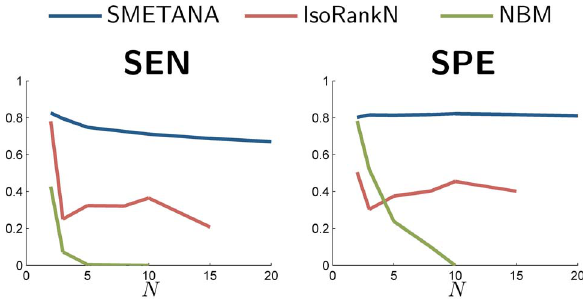
Figure 6. Performance on real networks. The trend of change in sensitivity (SEN) and specificity (SP) as the number of networks in the alignment increases for different multiple network alignment algo- rithms.